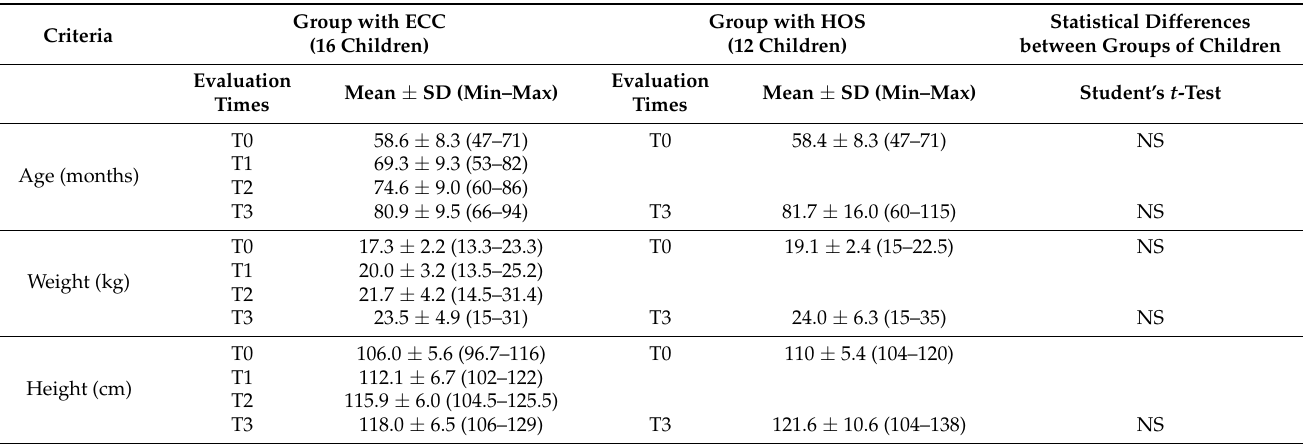
Table 1. Comparison of general health data between both groups of children throughout the study. Group with HOS Statistical Differences between Groups of Children(16 Children) (12